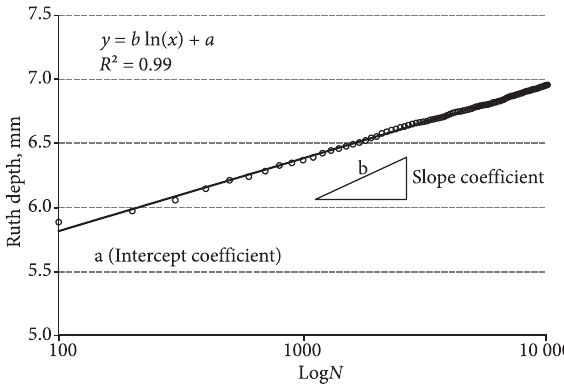
Fig. 4. Typical plot for intercept and slope coefficient copmutation